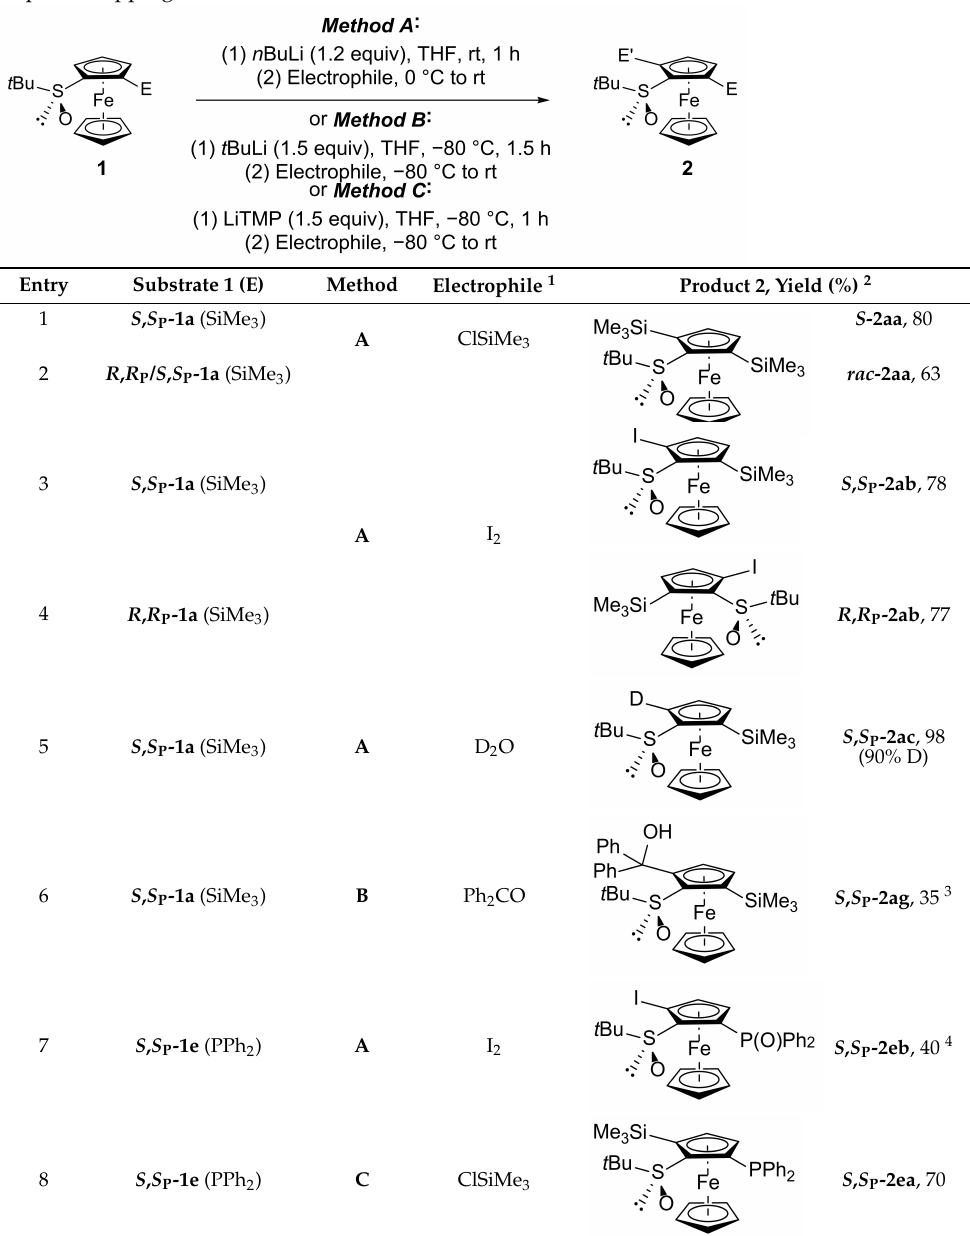
Table 2. Deprotometalation of 2-substituted S - tert -butylferrocenesulfoxides followed by elec- trophilic